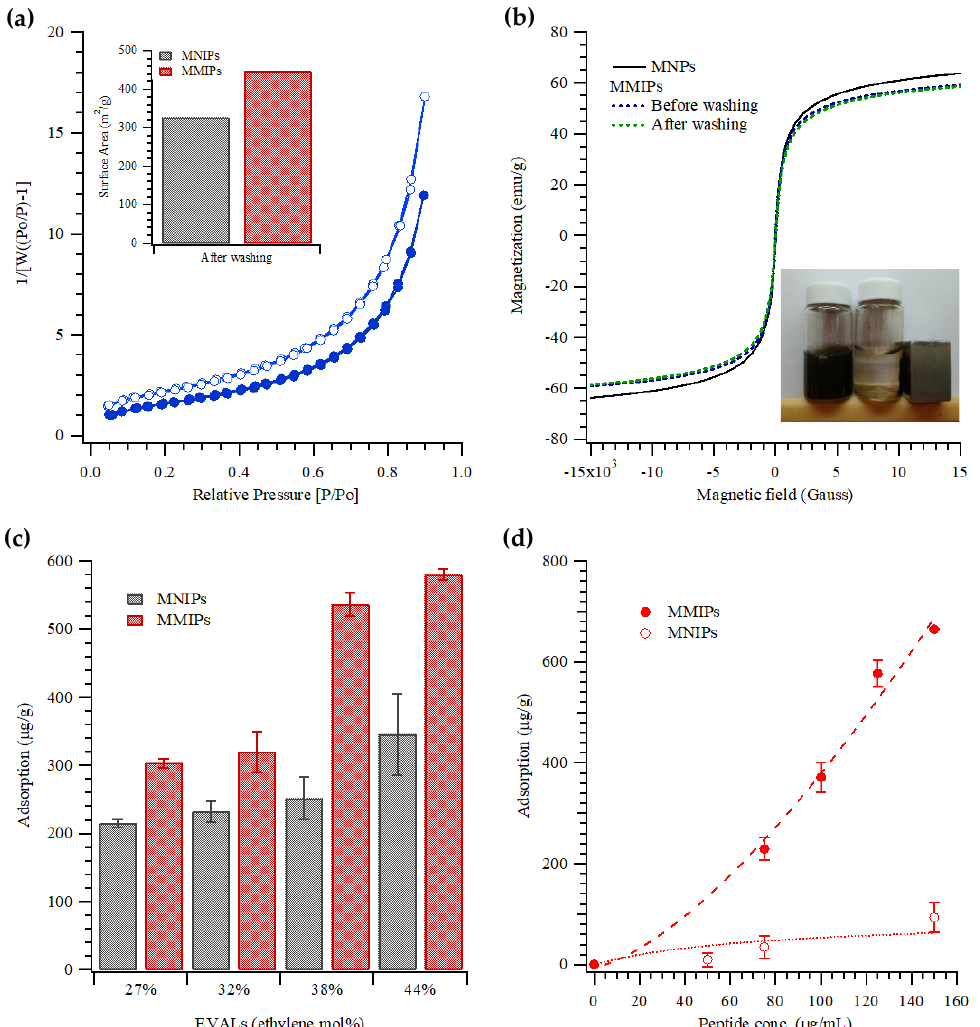
Figure 2. ( a ) BET analysis and specific surface areas (inset) of MNIP and MMIP nanoparticles. ( b ) SQUID magnetization measurement of MMIPs before and after template removal. MNPs are magnetic nanoparticles alone. ( c ) Peptide binding to imprinted and non-imprinted nanoparticles, showing increasing imprinting effectiveness with higher ethylene content. ( d ) Binding isotherm of MNIP and MMIP nanoparticles.